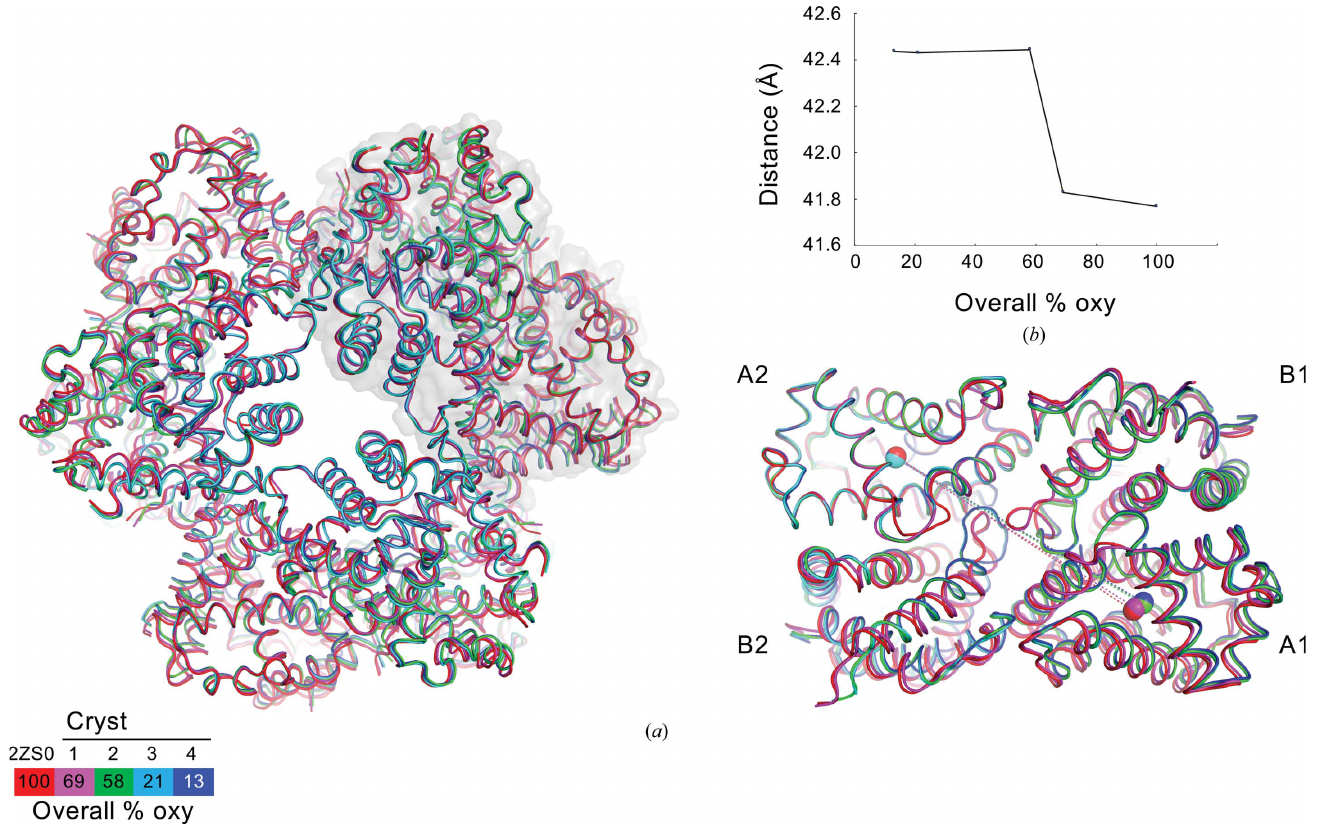
Figure 4 Quaternary-structural transitions in the overall structure. ( a ) Superposition of the 24-meric assemblies of Oli Hb. The color schemes are the same as in Fig. 3. A tetrameric subassembly is represented as a transparent surface model superposed on the overall structures, and a close-up view is shown in the right panel. The centers of gravity of each A1 and A2 subunit are represented as spheres of the same color. ( b ) Transition of the distance between the centers of gravity of the A1 and A2 subunits [dashed line in ( a